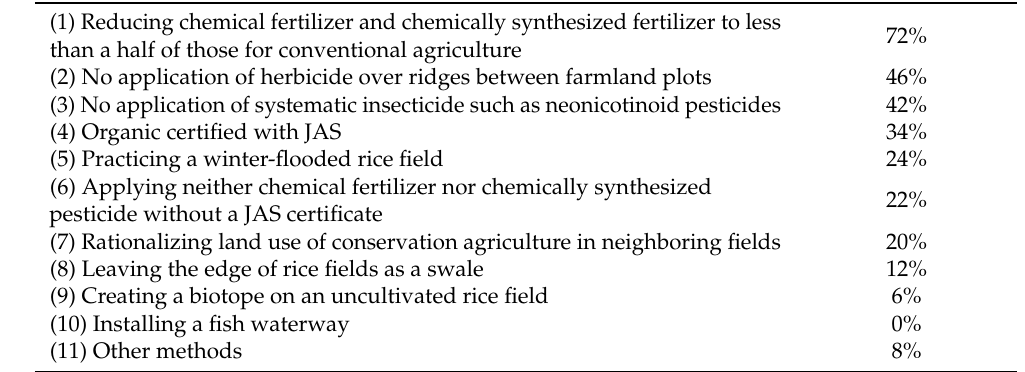
Table 2. Practicing methods of conservation agriculture ( n = 50, multiple answers